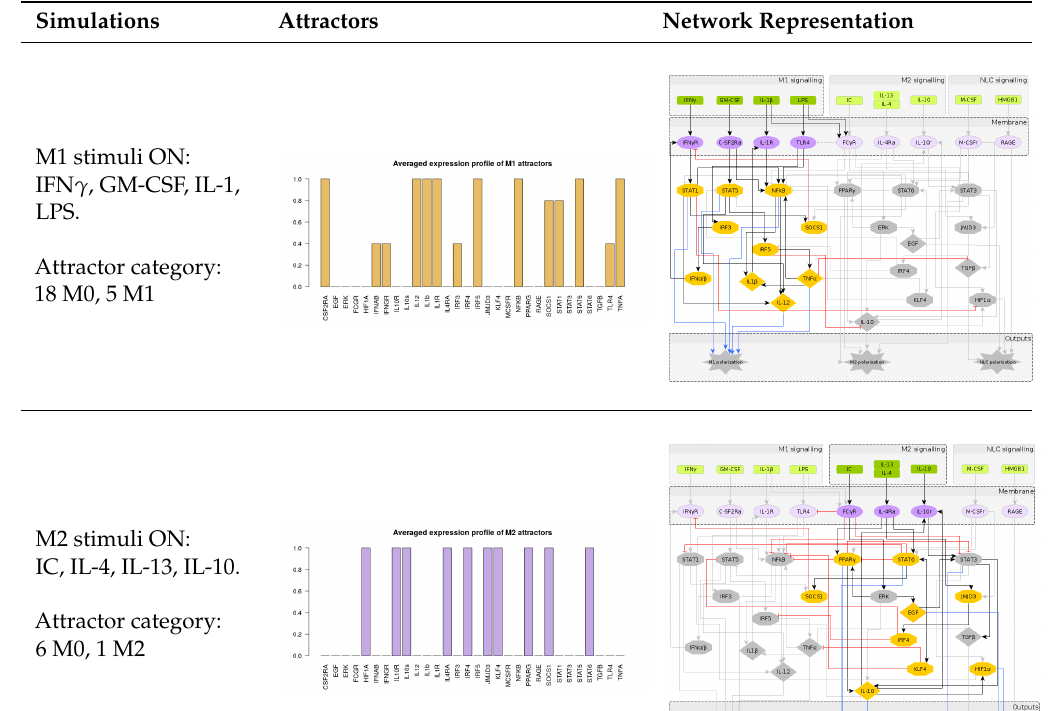
Table 3. Simulations of environmental signals consisting of M1-, M2- and NLC-inducing signals